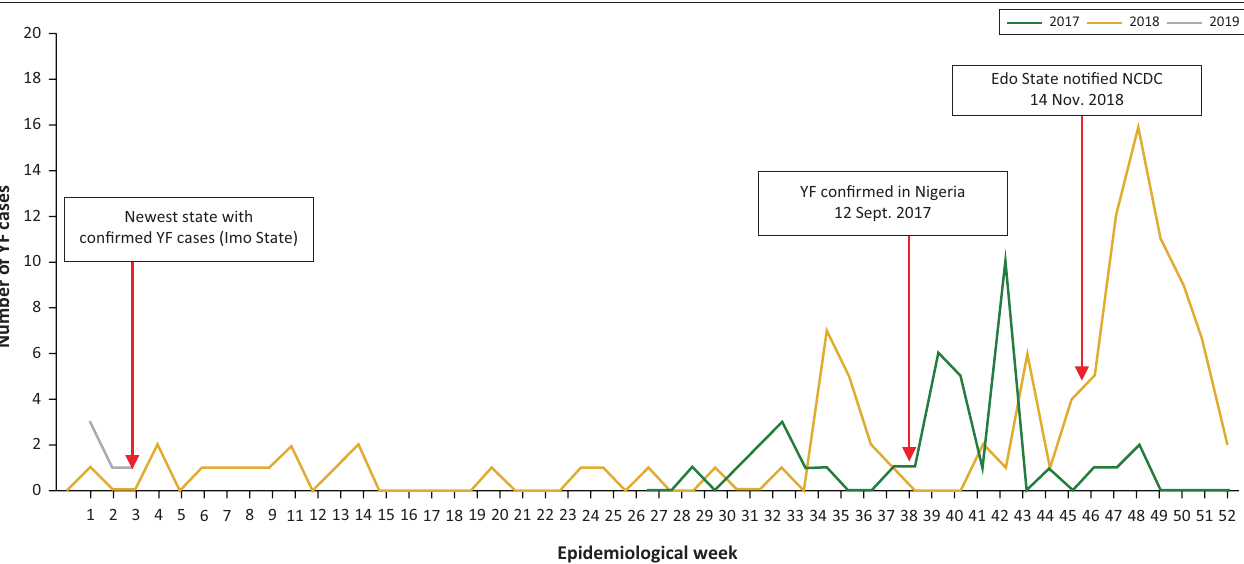
FIGURE 1: Weekly trends of yellow fever outbreak in Nigeria from 2017 to